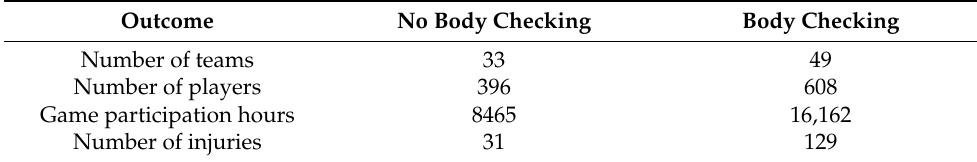
Table 2. Summary of recruitment, game participation hours and game-related injuries.